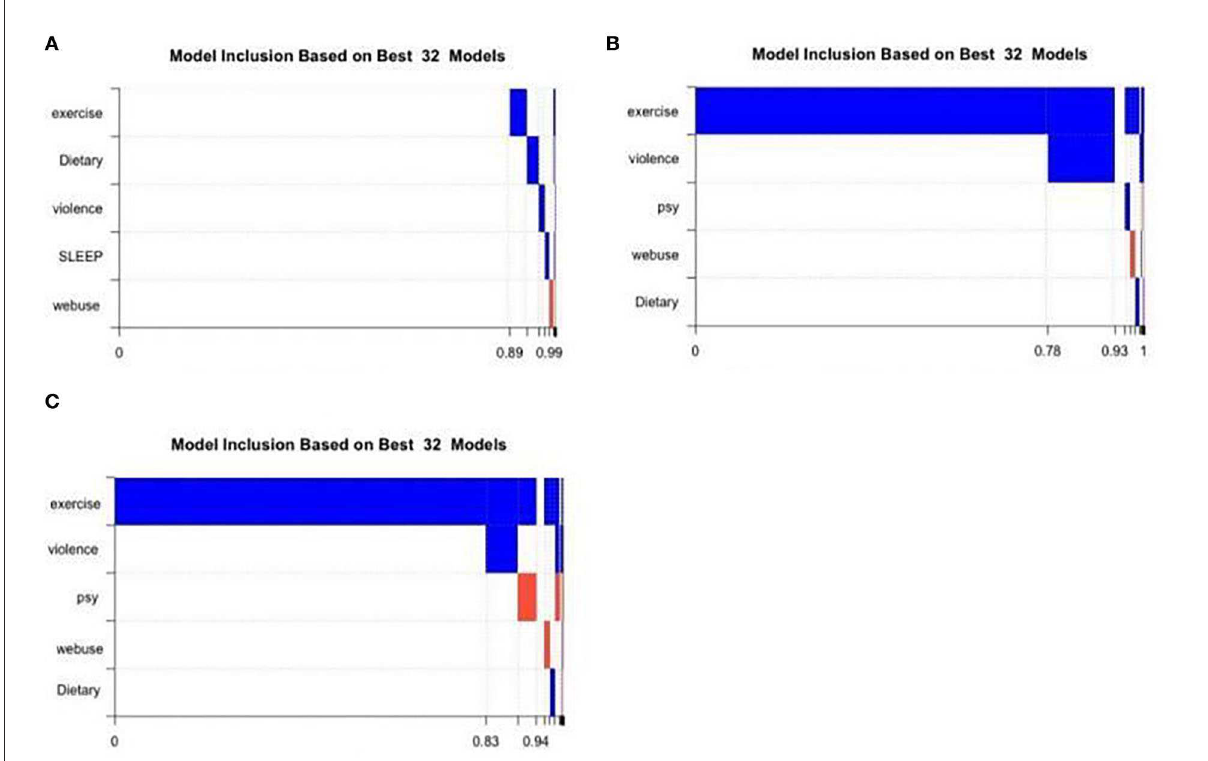
FIGURE3 Variables inclusion in the 32 models of different stages. Violence refers to “school bullying”; psy refers to “mental stress”. (A) Cumulative model probabilities of primary school students. (B) Cumulative model probabilities of junior high school students. (C) Cumulative model probabilities of high school